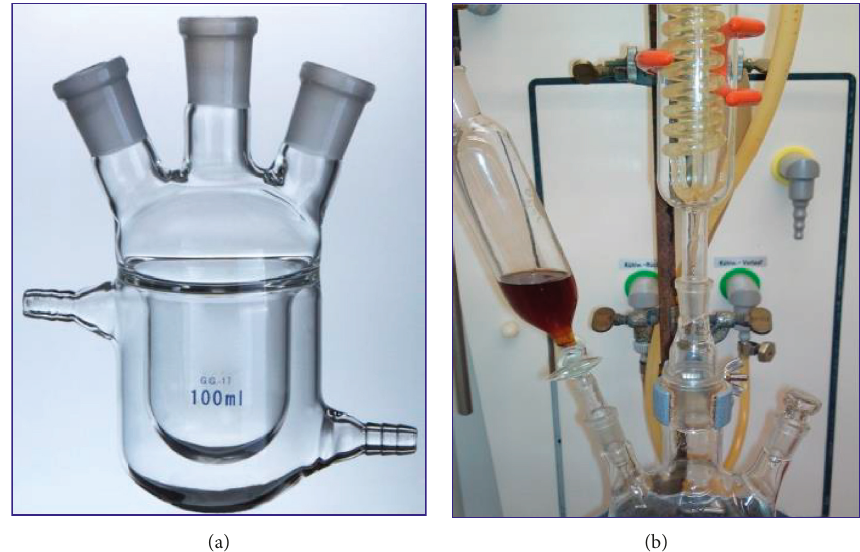
Figure 1: Glass jacketed flask reactor vessel round bottom flask beaker double layer three necks and the complete synthesis